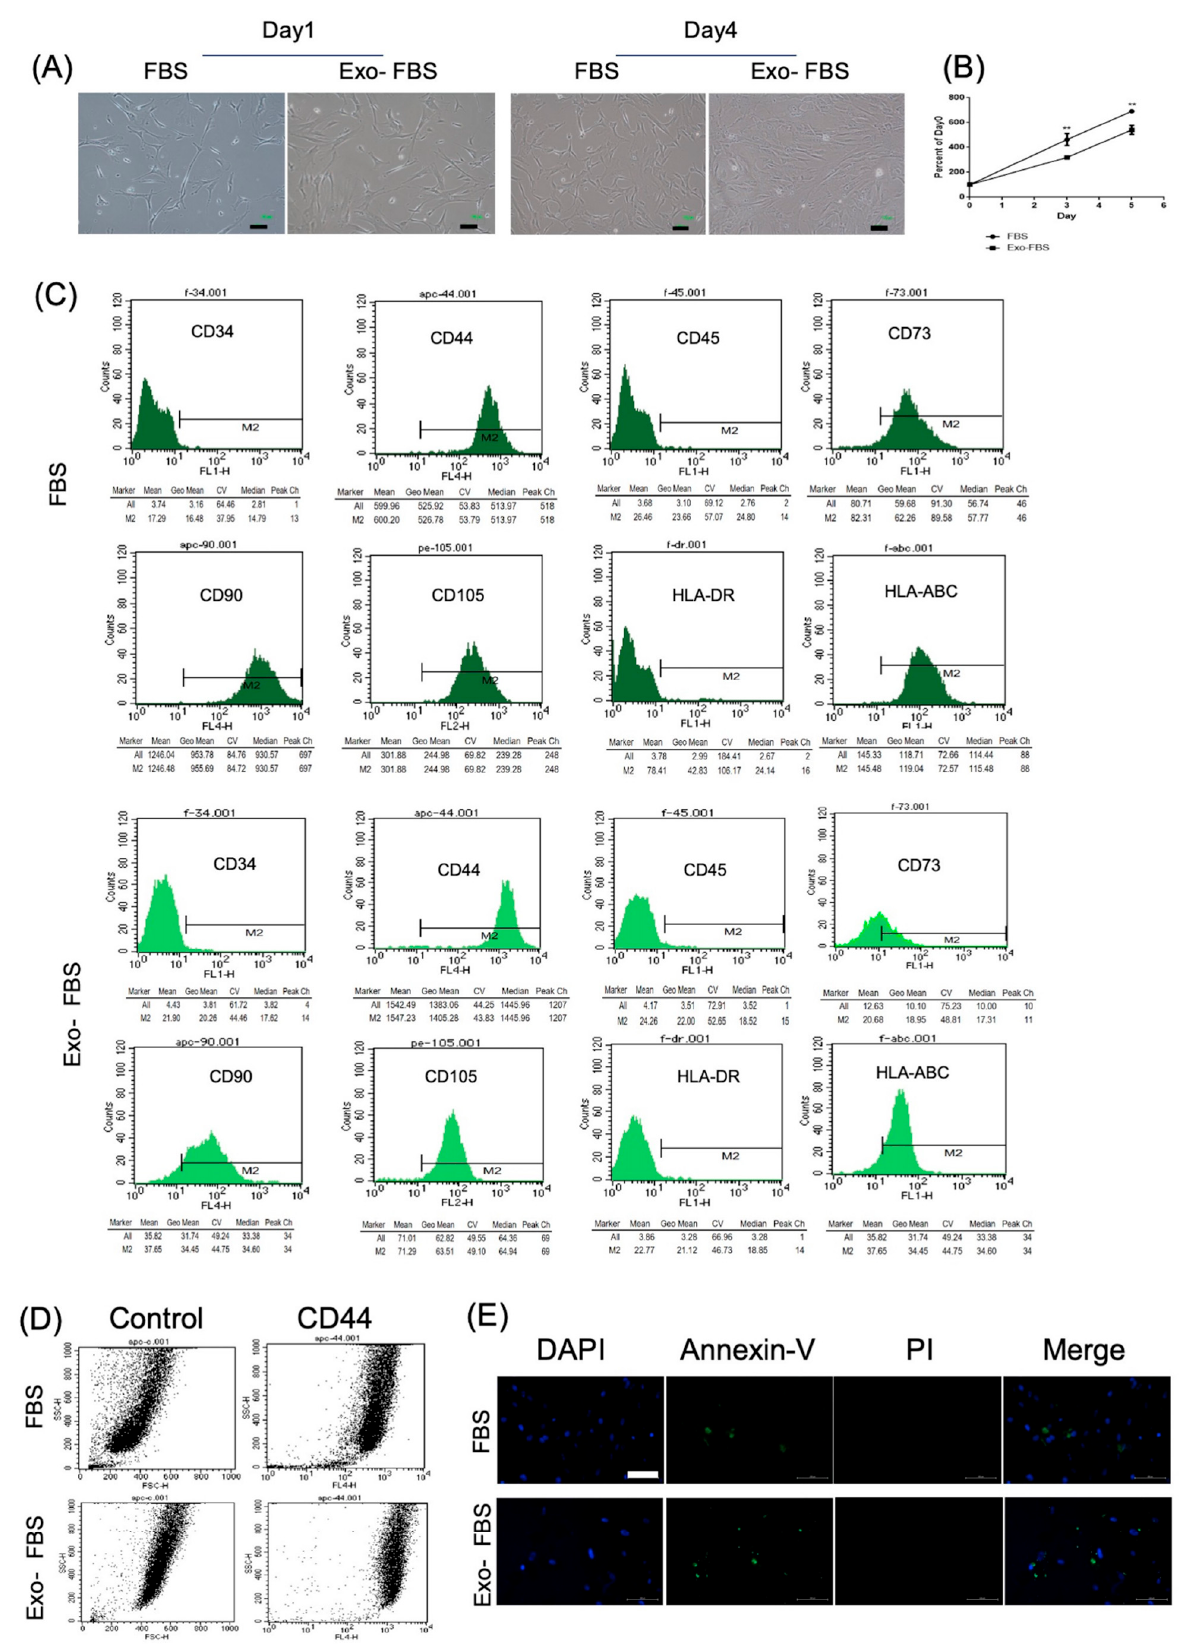
Figure 1. Morphology, proliferation, and surface markers of HUCMSCs cultured with exosome- depleted (Exo(-)FBS) and conventional fetal bovine serum (FBS). ( A ) Morphology of the